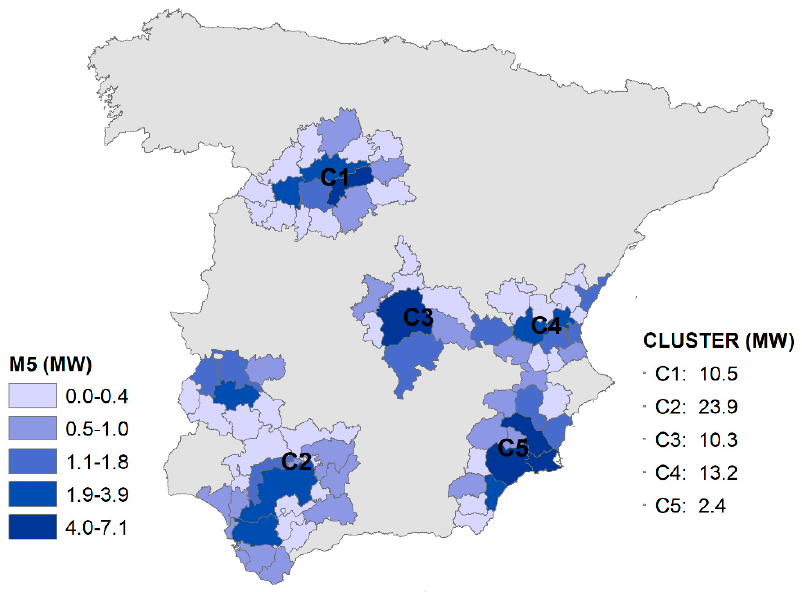
Figure 5. Geographical distribution of the power potential and clusters’ power for mixture M5.